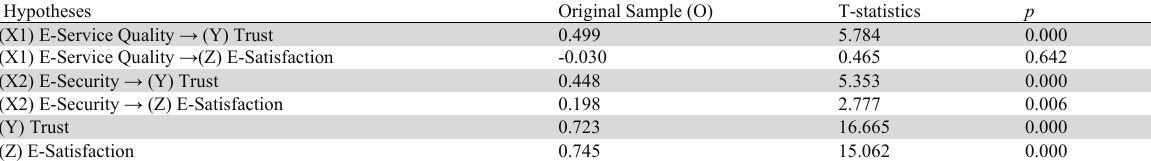
Hypothesis Testing